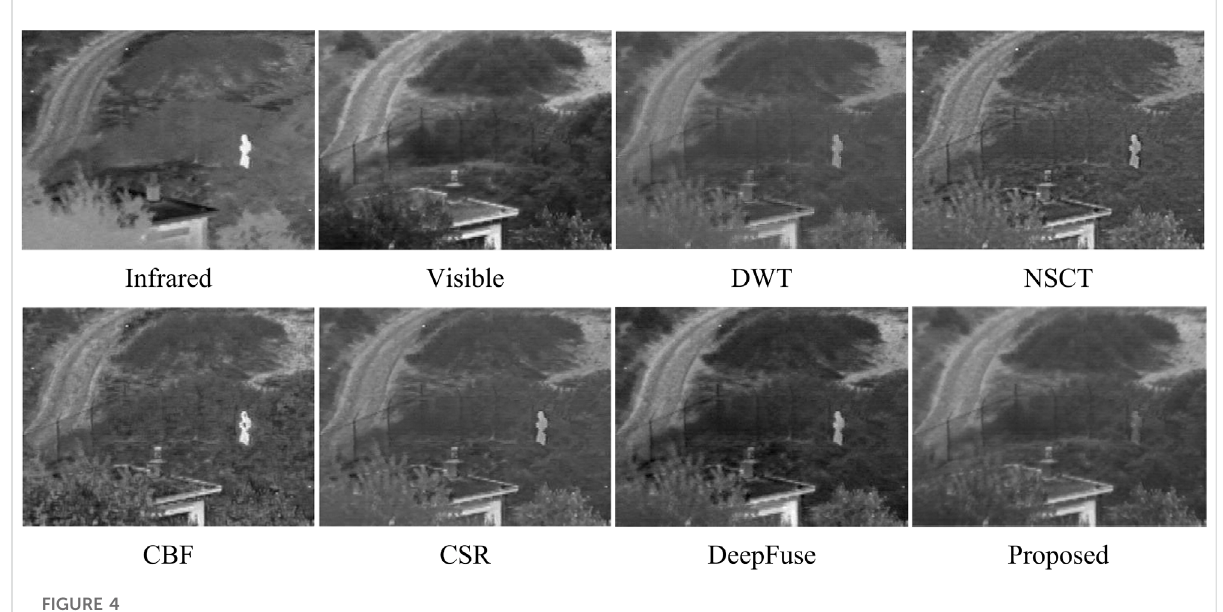
FIGURE 4 Fusion results with different comparison methods on image (a).